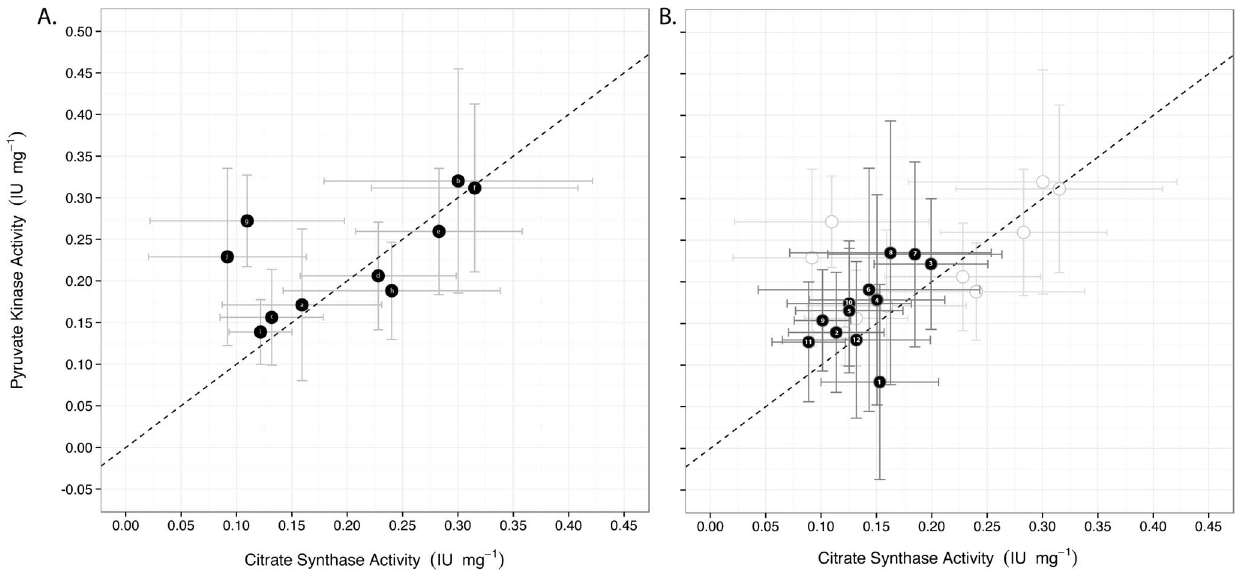
Figure 2. Relationship between citrate synthase and pyruvate kinase activity (IU mg wet tissue 2 1 ) in mantle tissues in A field collected clams and B clams from laboratory experiment. Values represent means + / 2 SE, n=6 for each point. In A, letters within the points identify each environmental variable combinations at the time of clam collection (temperature, u C | salinity | chlorophyll a concentration, m g L 2 1 ), a) 16.7 | 12.5 | 0.8, b) 11.1 | 11.2 | 0.9, c) 8.3 | 1.2 | 0.4, d) 12 | 0.1 | 1.3, e) 14.8 | 0.0 | 3.6, f) 15.8 | 0.1 | 4.0, g) 19.5 | 0.1 | 2.2, h) 20 | 1.9 | 1.9, i) 20.3 | 6.3 | 1.6, j) 18.3 | 0.1 | 1.5. In B , numbers within the points identify each treatment combination (salinity | temperature, u C | food level). 1) 2 | 12 | High, 2) 2 | 12 | Low, 3) 2 | 18 | High, 4) 2 | 18 | Low, 5) 8 | 12 | High, 6) 8 | 12 | Low, 7) 8 | 18 | High, 8) 8 | 18 | Low, 9) 15 | 12 | High, 10) 15 | 12 | Low, 11) 15 | 18 | High,